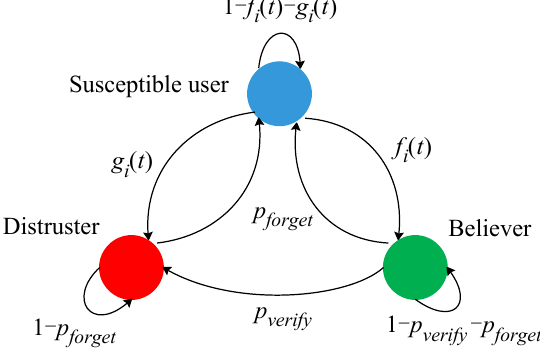
Figure 11. State transition model